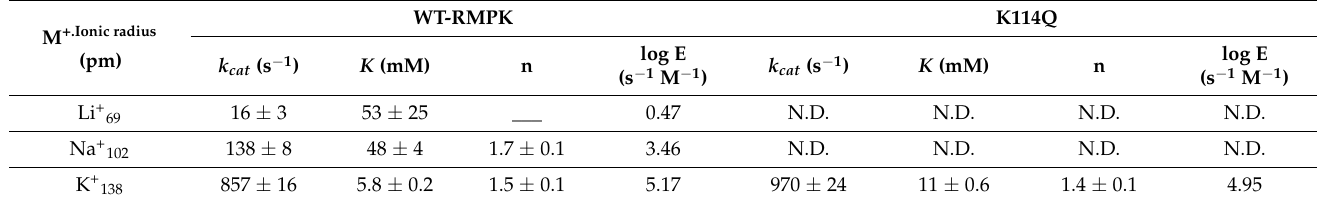
Table 1. Kinetics of the activation of WT-RMPK and K114Q mutant by monovalent cations at saturating concentrations of PEP 3 − , Mg-ADP complex, and Mg 2+ free .The data from Figure 3A were fitted to the Michaelis–Menten equation ( v = V max S/K m + S ) and to the Hill equation ( v = V max S n / K 0.5 n + S n ) (Origin version 7.0). The mean and standard deviation from three experiments are shown. k cat / a K values are expressed in log